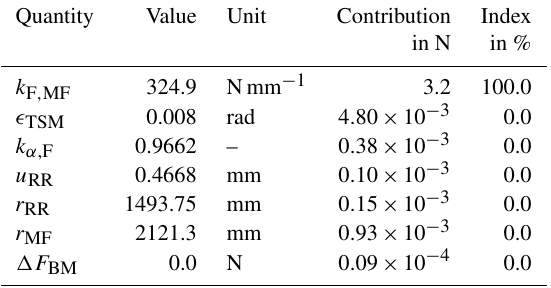
Table 2. Measurement uncertainty budget of FT with a calibration torque moment of 5MNm at the upper MF.